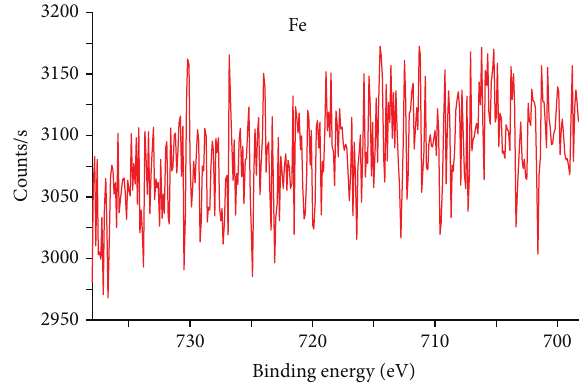
Figure 3: XPS spectra of the 4.50% Fe-TNT